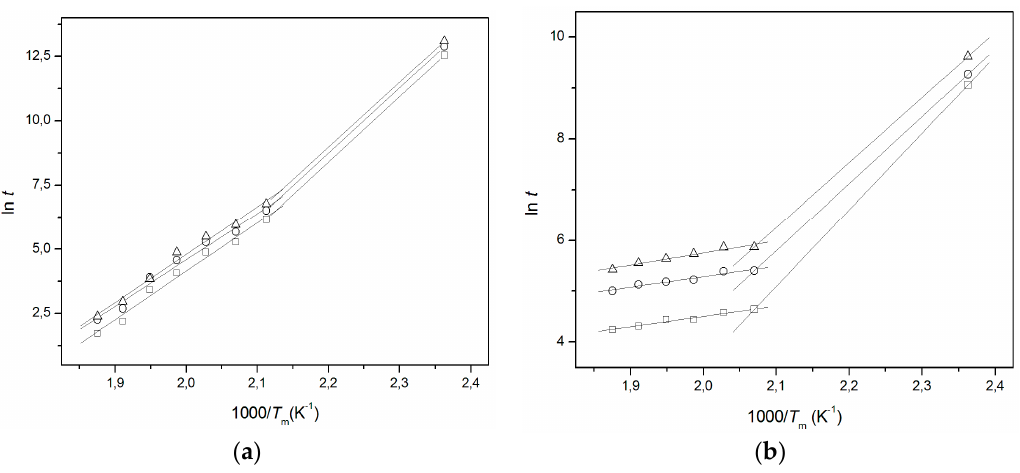
( a ) ( b ) Figure 4. MacCallum straight lines at various D values: 5% ( (cid:3) ), 7.5% ( ), 10% ( (cid:52) ) for ( a ) PE and ( b ) PS. Table 2. Sample code, abbreviation, molecular weight ( M w ), glass-transition temperature ( T g ), onset melting temperature ( T onset ), and time of long-term experiment of the tested polymeric materials. Sample